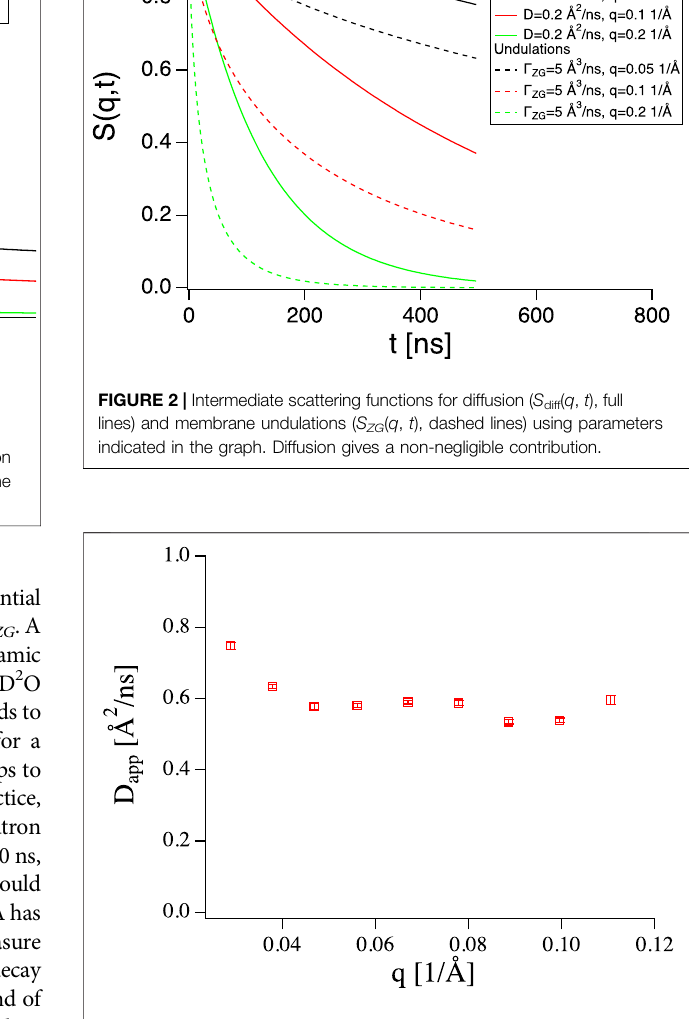
FIGURE3| Apparentdiffusioncoef fi cient obtained from fi ttingNSE data of 100 nm vesicles (2 mg/ml) with a simple exponential. The value is too large for simple diffusion, but no q 3 dependence is